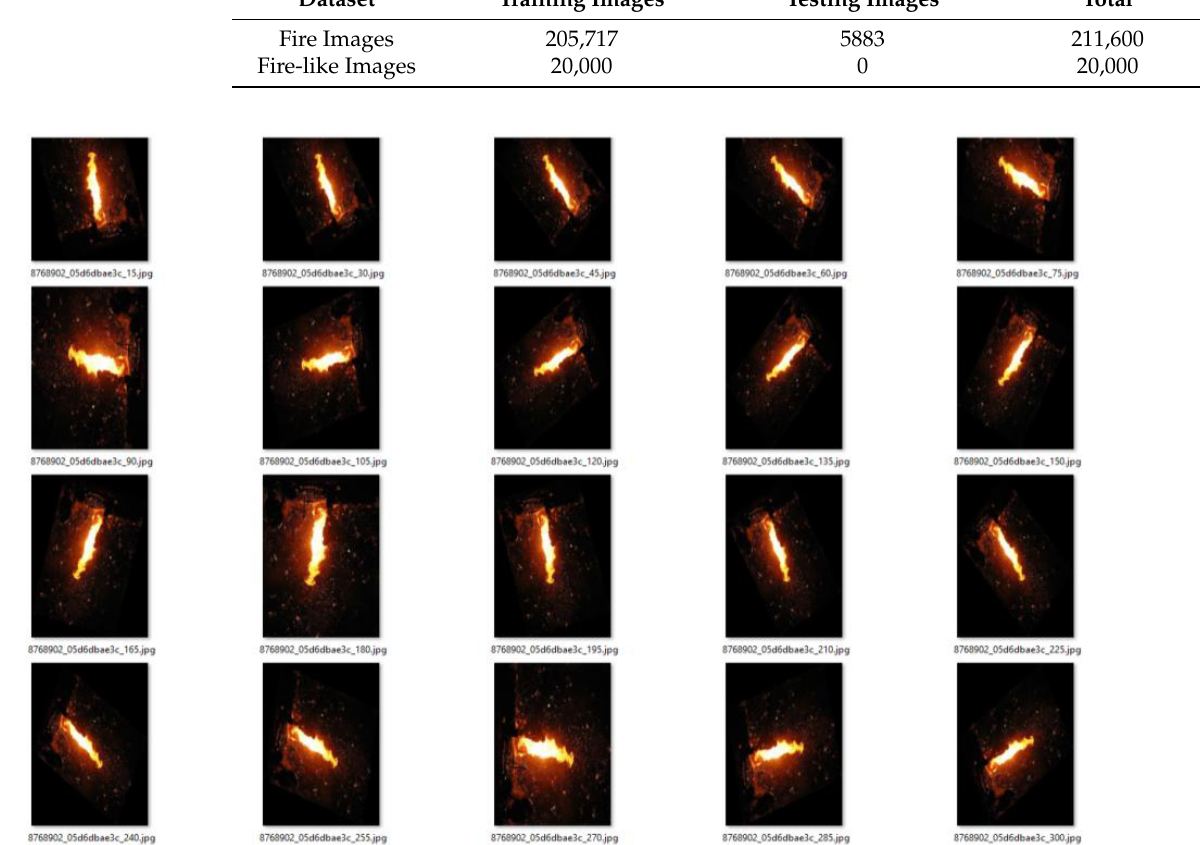
Figure 1. Examples of fire image rotation process.